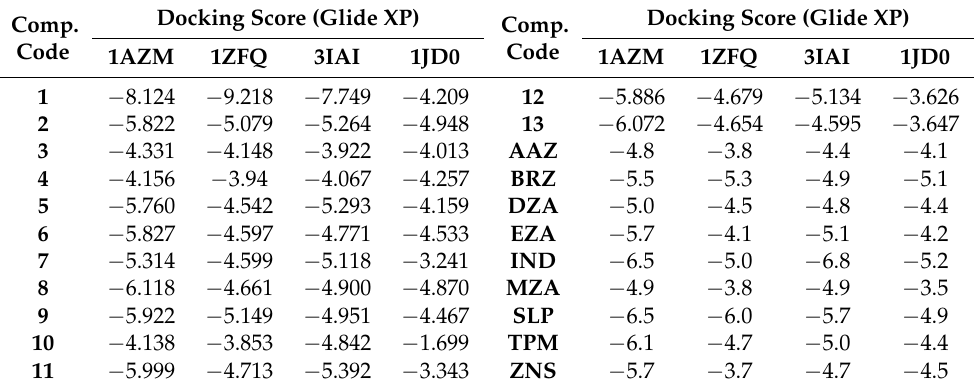
Table 3. Human CAs docking scores of sulphonamides 1–13 and other clinically used CAIs. Comp.